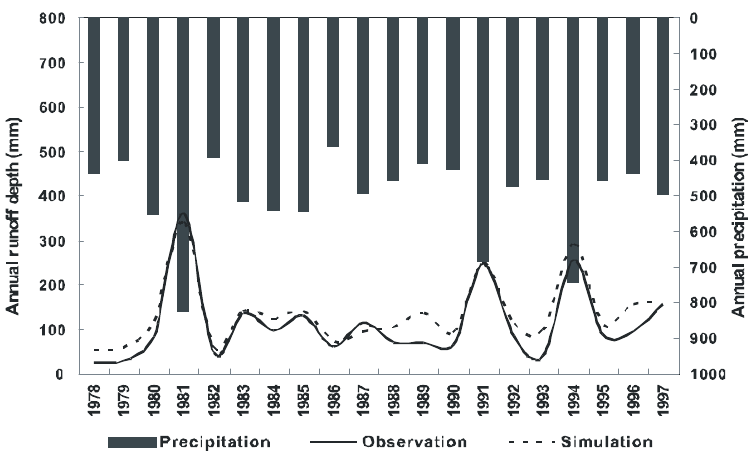
Figure 5. Annual precipitation and simulated and observed runoff depth using the SWAT model in the upper Naoli River watershed, during 1978–1997.